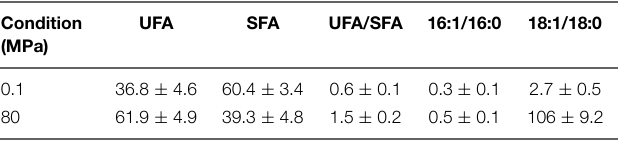
TABLE 3 | Percentages and ratios of total unsaturated fatty acid (UFA) and saturated fatty acid (SFA) ethyl esters in relation to HPH treatments (0.1 or 80 MPa) in the presence of exogenous